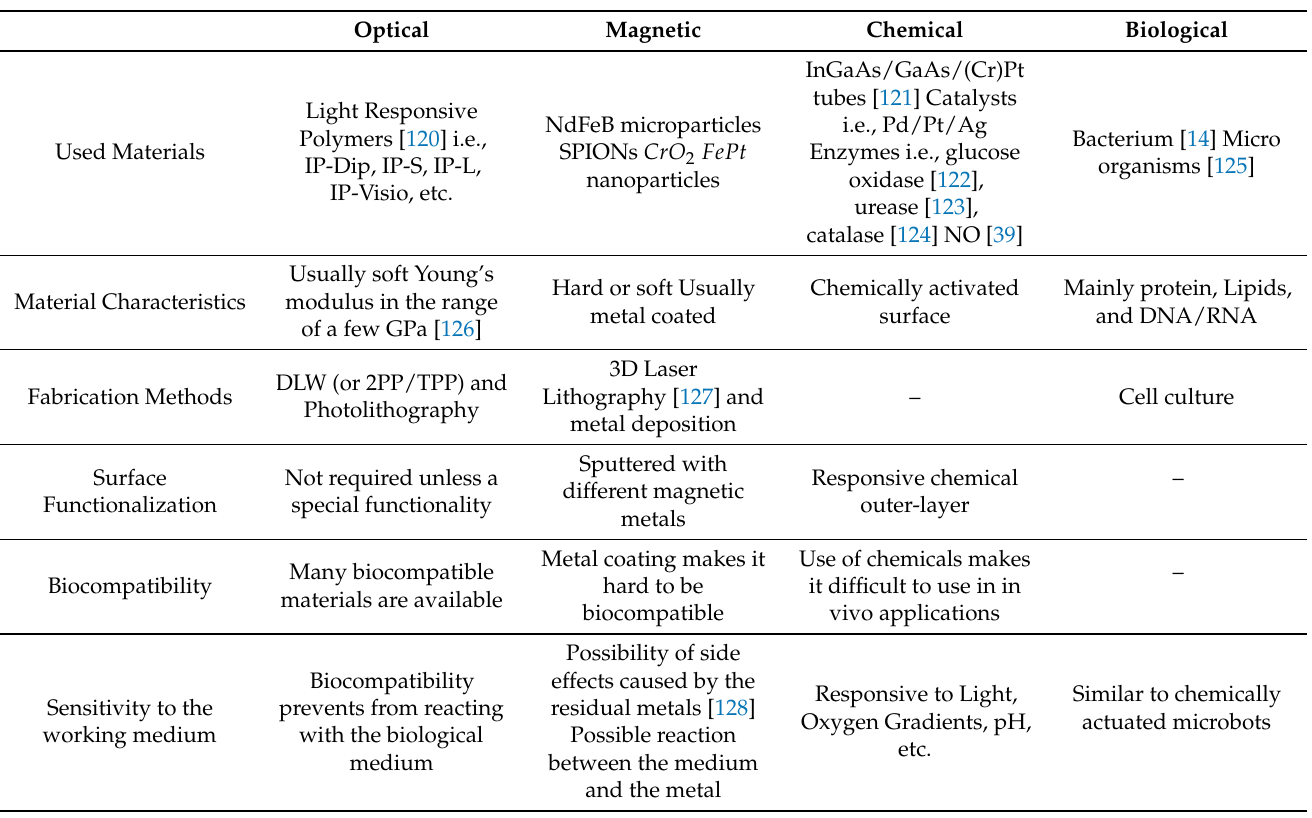
Table 1. Comparison between different control